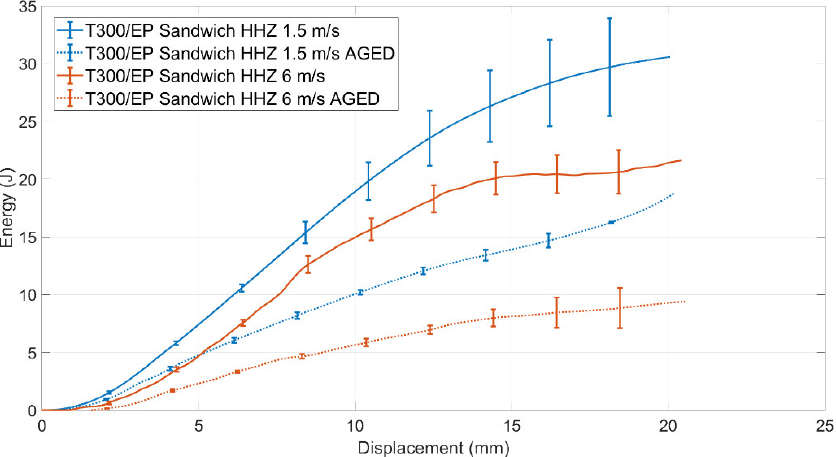
Figure 4. Energy-displacement mean curves for untreated or aged specimens of sandwich with Kraibon HHZ.